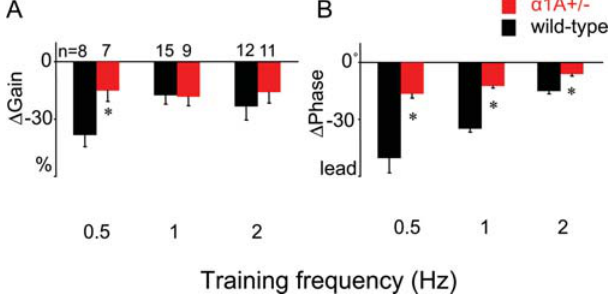
Figure 4. Effect of training frequency on the learned changes in VOR gain (A) and phase (B). Frequency-selective impairment of changes in VOR gain (A) and frequency-independent impairment of changes in VOR phase (B) in a 1A + / 2 mice (red) relative to wild-type mice (black) during x1/90 u lead training. Data for 1 Hz are the same as in Fig. 2 (training paradigm ‘a’). A different set of wild-type and a 1A + / 2 mice was tested at 0.5 and 2 Hz. *: p , 0.017 by Bonferroni-corrected t-